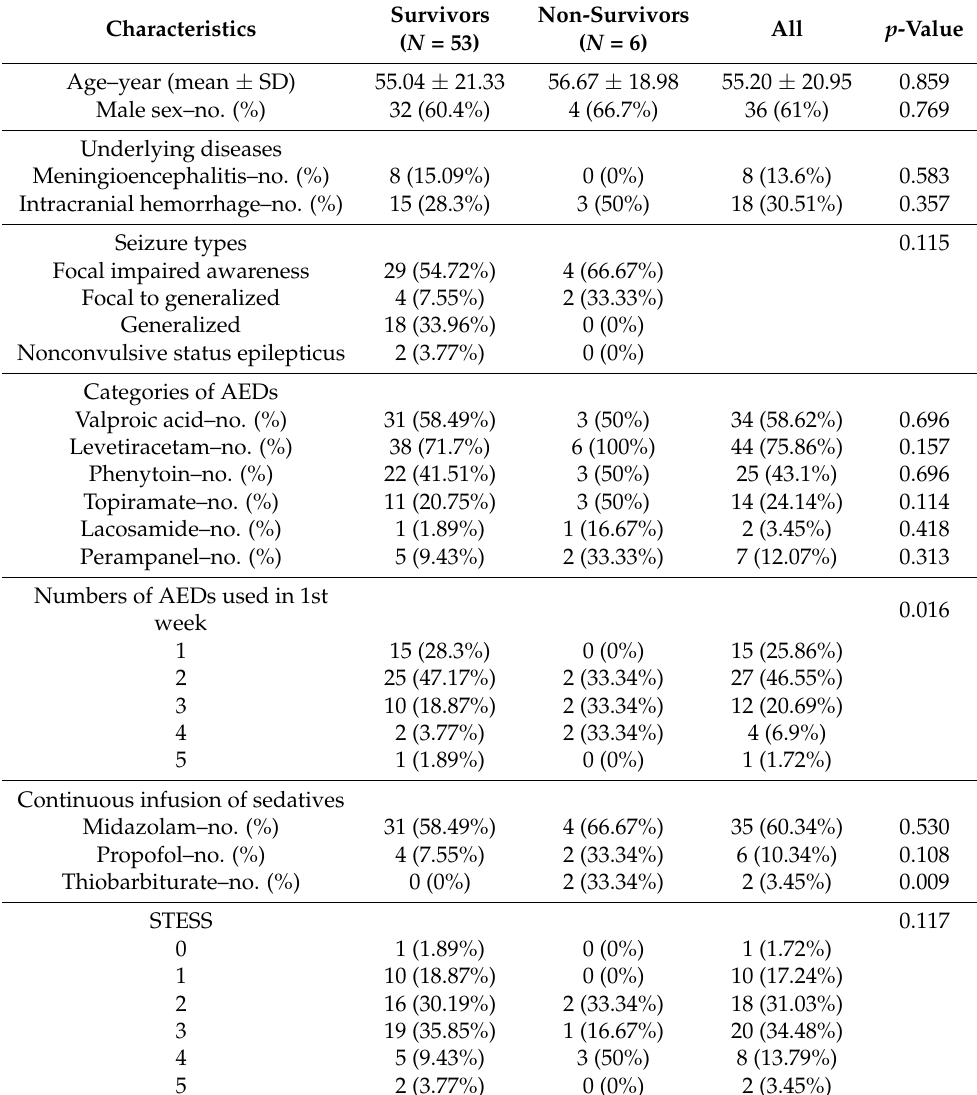
Table 1. Clinical characteristics of the survivors and non-survivors hospitalized in NCKU